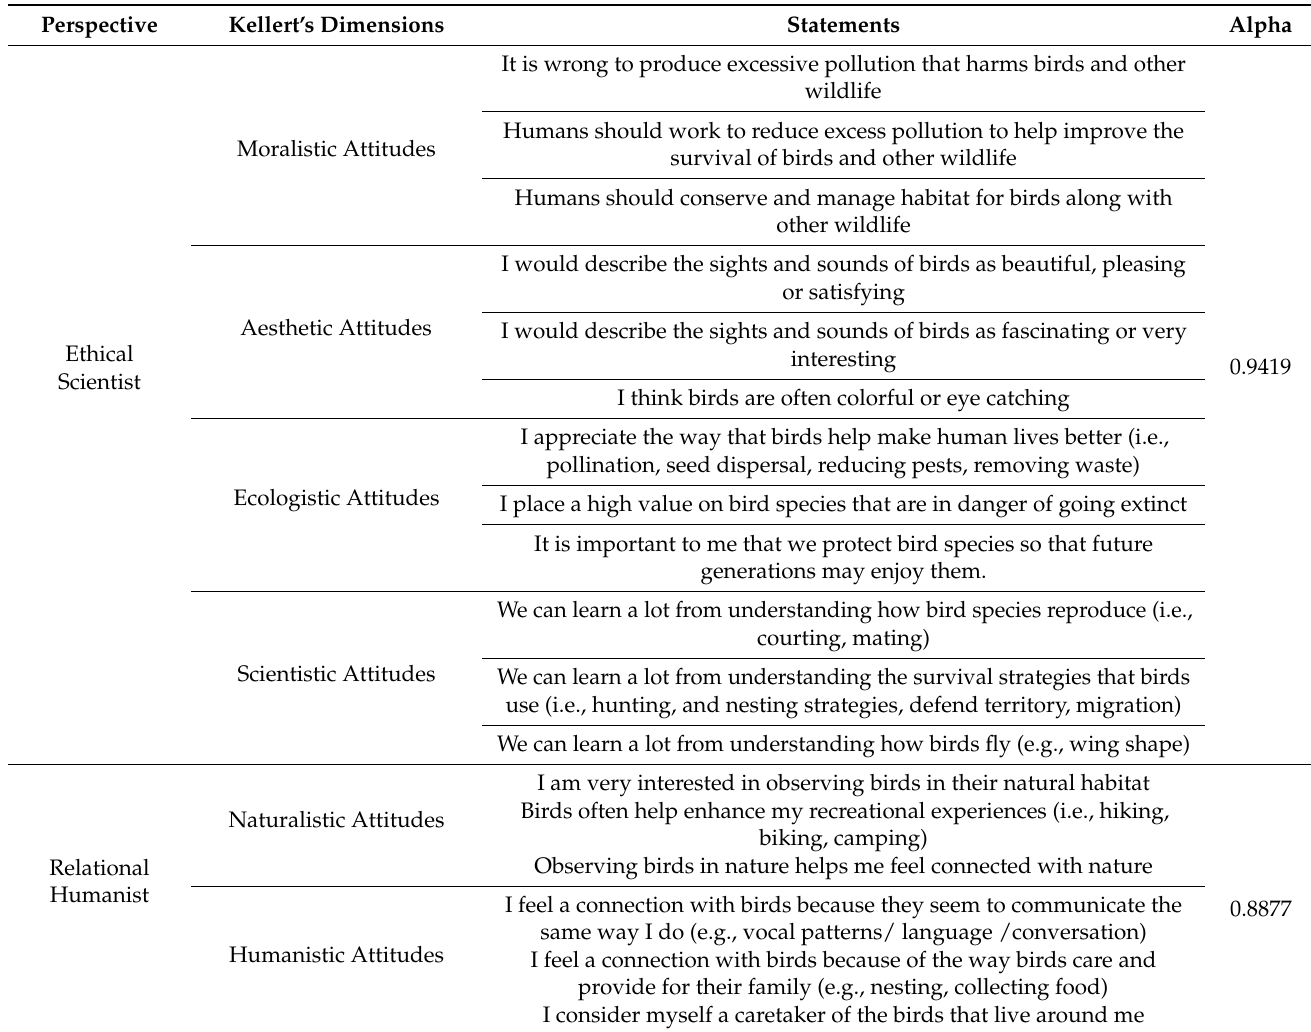
Table 1. Statements representing four common perspectives about birds across nine attitudinal dimensions ( n = 656).